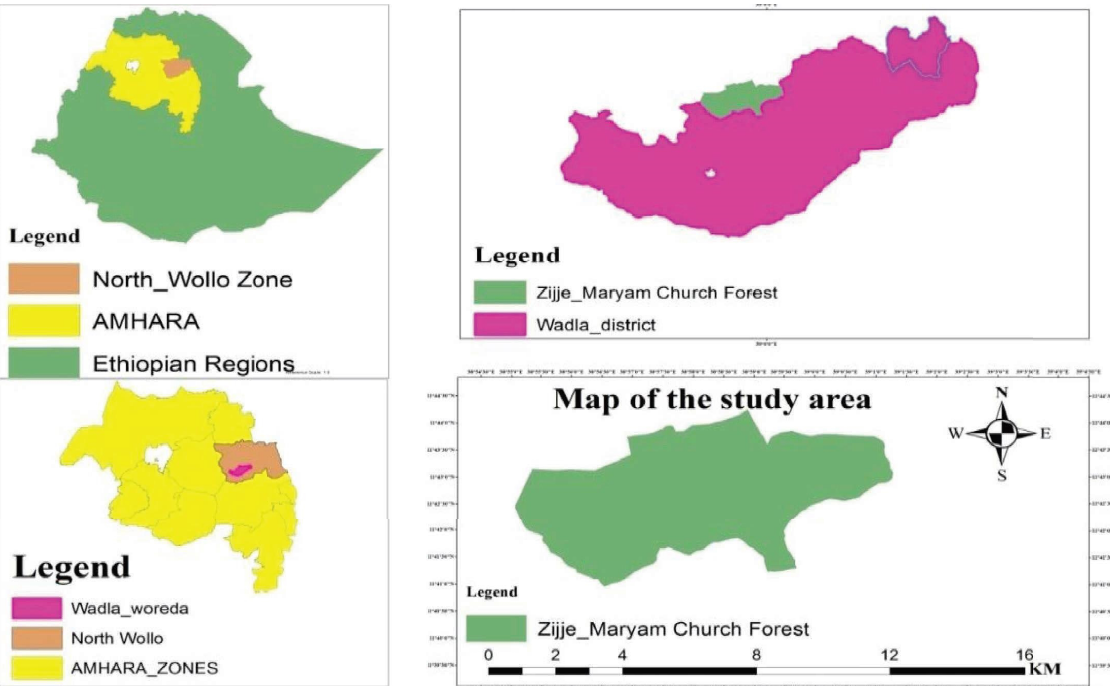
Figure 1: Location map of the study area.